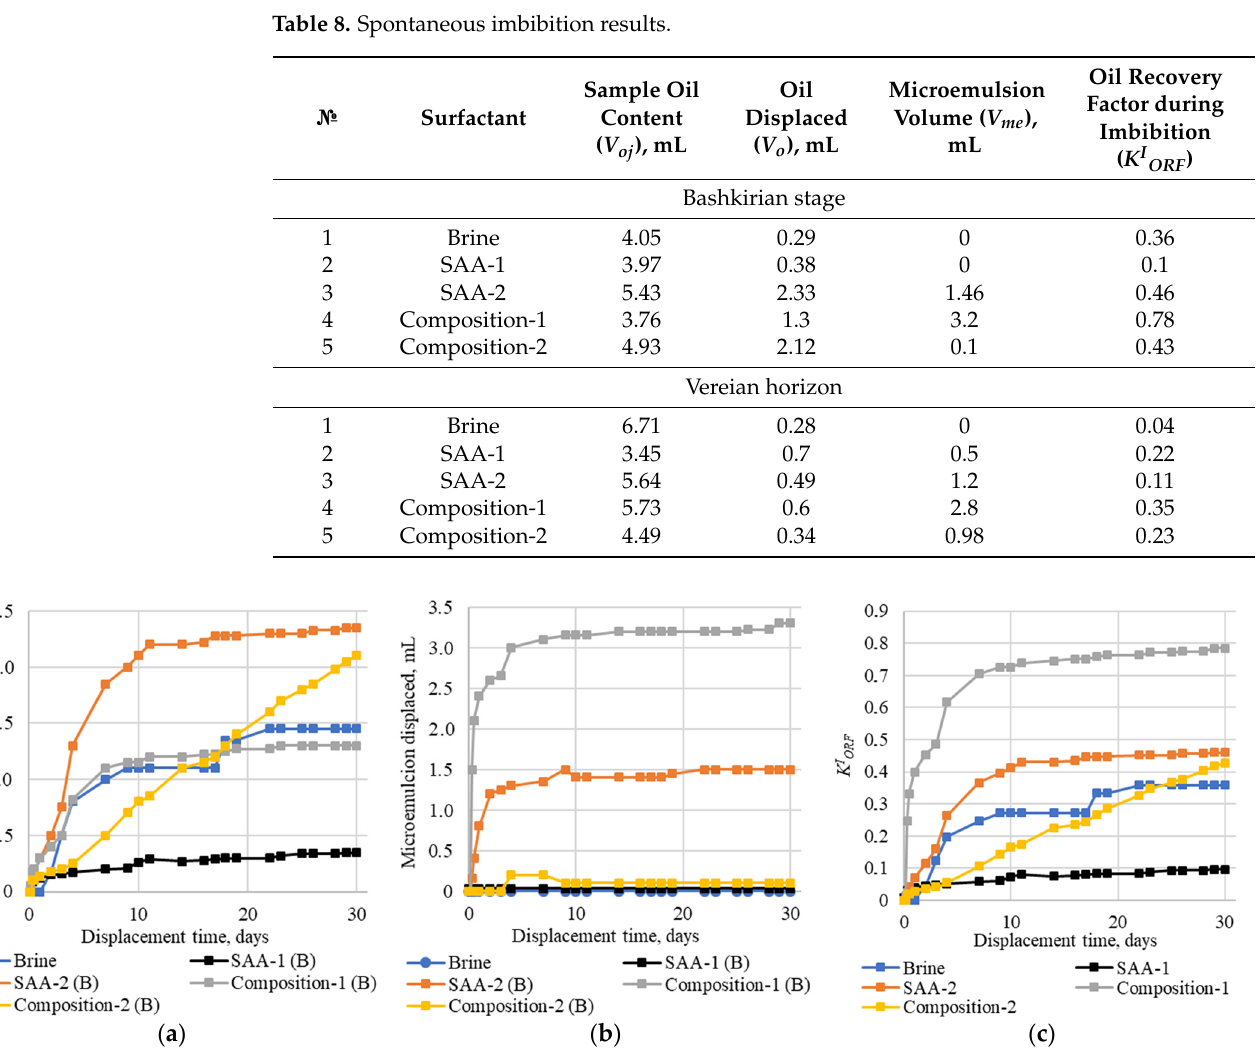
Table 8. Spontaneous imbibition results.